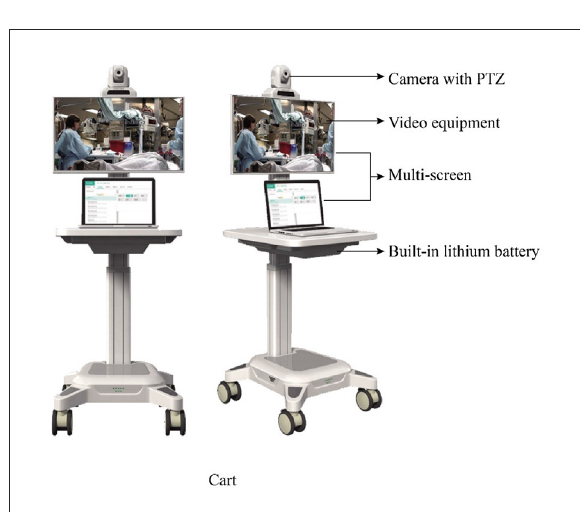
FIGURE5 Schematic diagram of CMEC remote ward rounds.